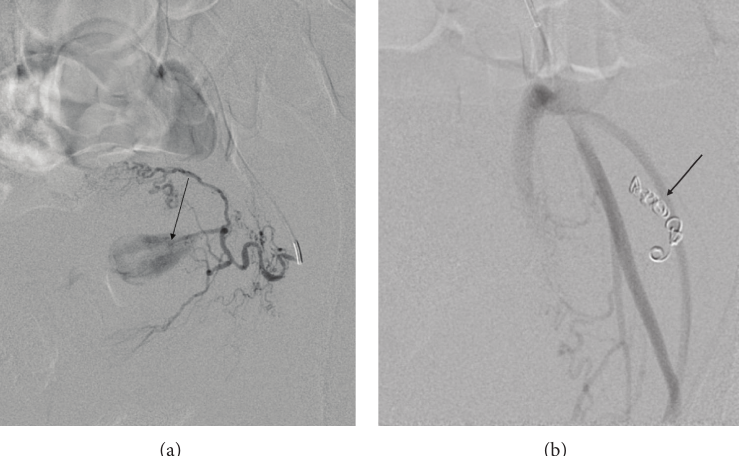
Figure 2: Angiography of the left uterine artery shows contrast leakage from a cervical branch of the artery (a) and complete occlusion of the uterine artery (b) after PVA particles and coils were administered